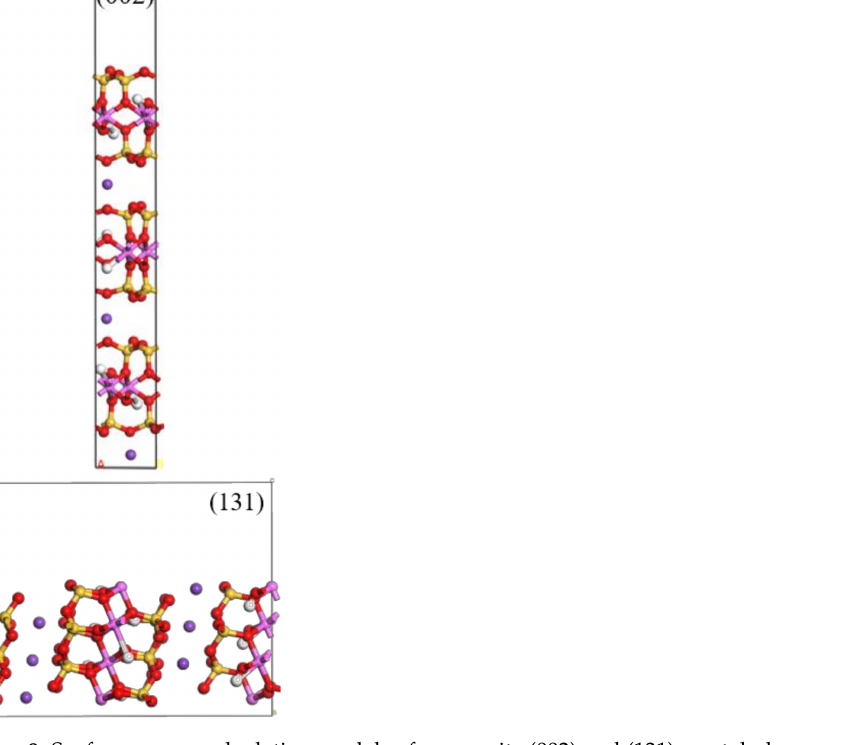
Figure 8. Surface energy calculation models of muscovite (002) and (131) crystal planes.